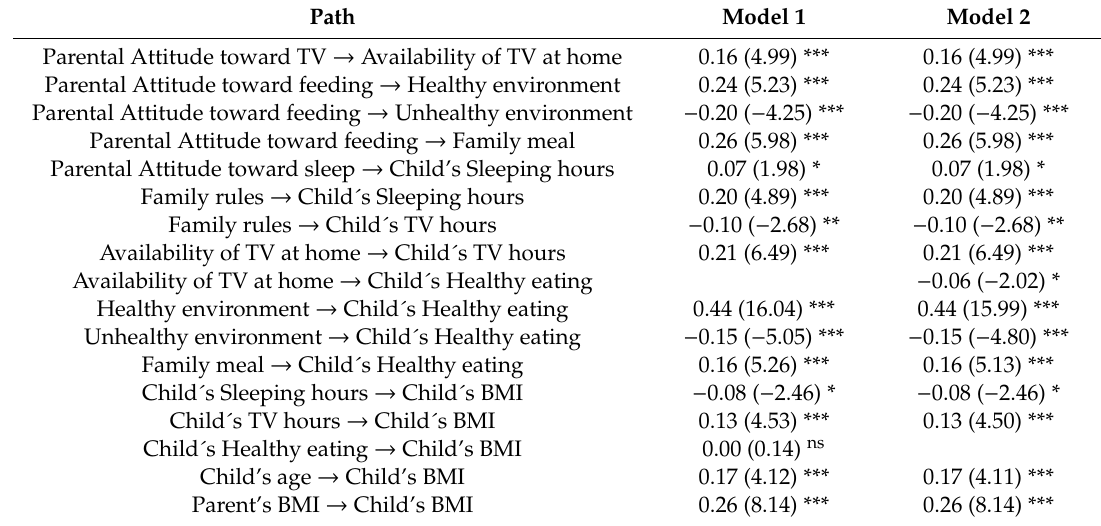
Table 4. Structural equation modeling results for hypothesis testing. Standardized betas